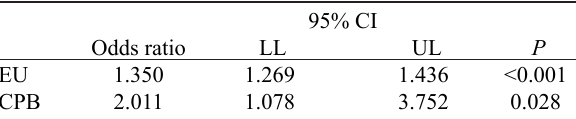
Table 3. Logistic regression model showing odds ratio values for the EU and the presence of CPB